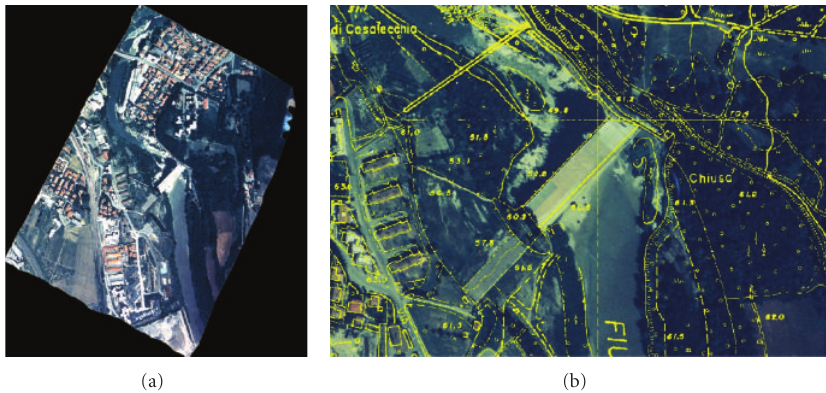
Figure 9: The orthophoto (a) and the superimposition of vector map on a detail related to the sluice area (b).